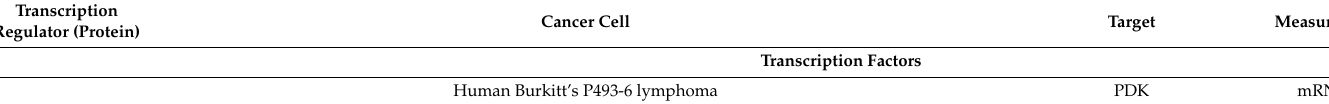
Table 3. Transcription regulators of cancer oxidative